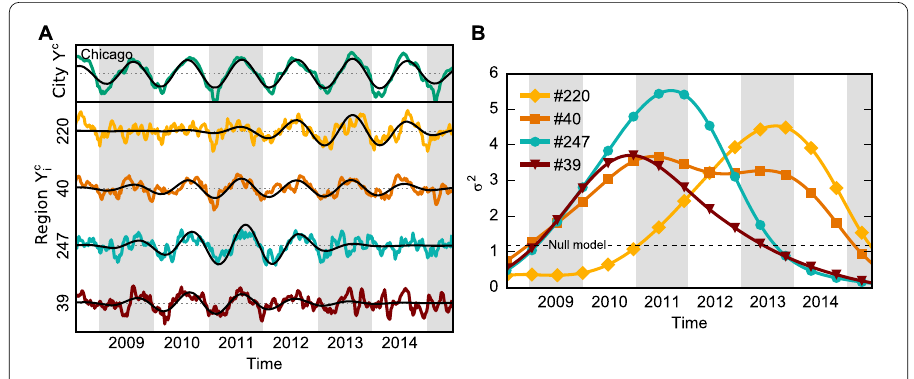
Figure 3 The circannual waves of crime are non-stationary at local level. In the plots, four selected regions of Chicago, IL. Though the circannual period is stationary at city-level, ( A ) the periodicity changes throughout the time series. To track the non-stationarity in the regions, we used ( B ) the scale-averaged wavelet power of the wavelet transform of Y c